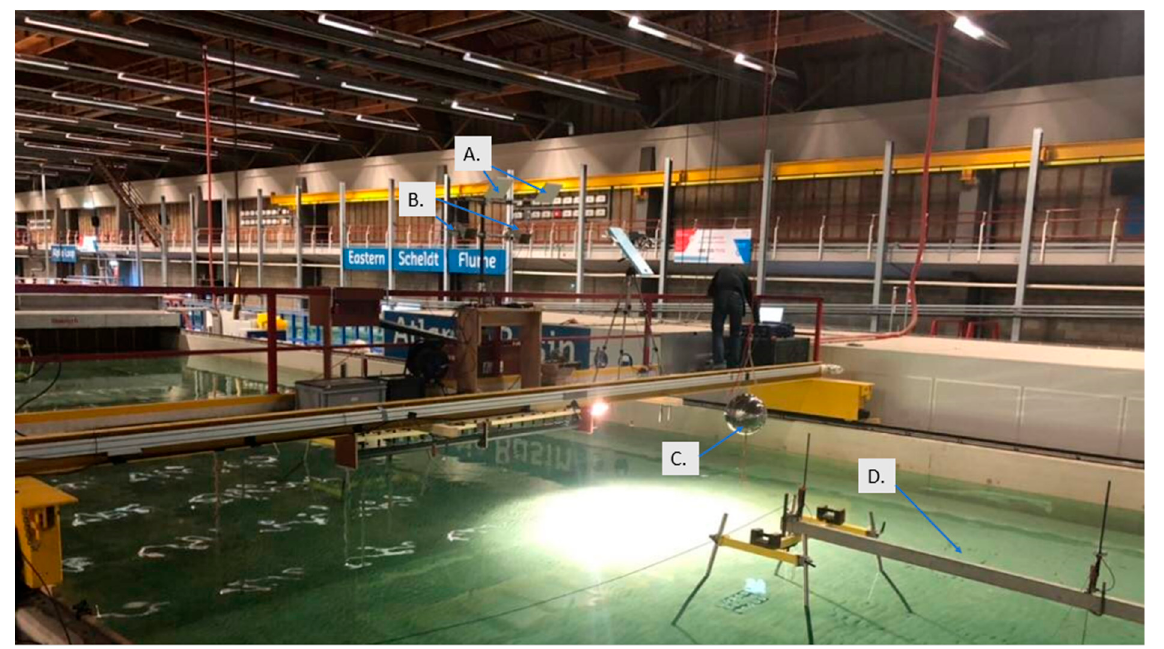
Figure 2. Measurement set-up located inside the Atlantic Basin Wave Facility. ( A , C )-band antenna; ( B ) X-band antenna; ( C ) external sphere used for calibration. ( D ) Additional wave gauges that were removed during measurement campaign testing.